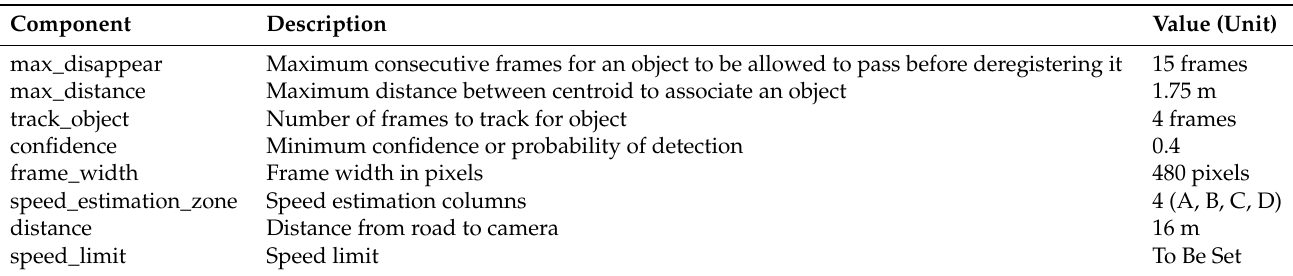
Table 5. Final calibration of the system